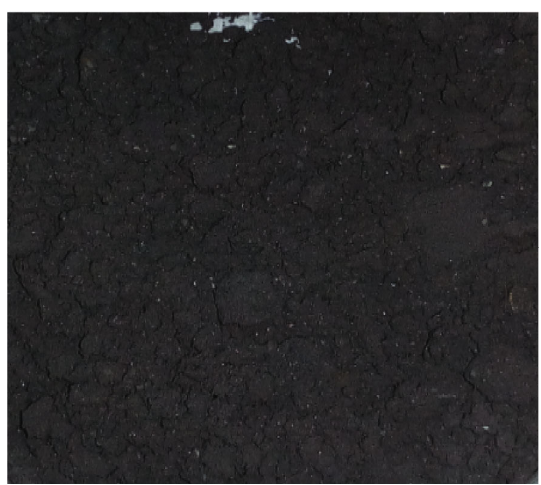
Figure 1: Ferrous fractions extracted from